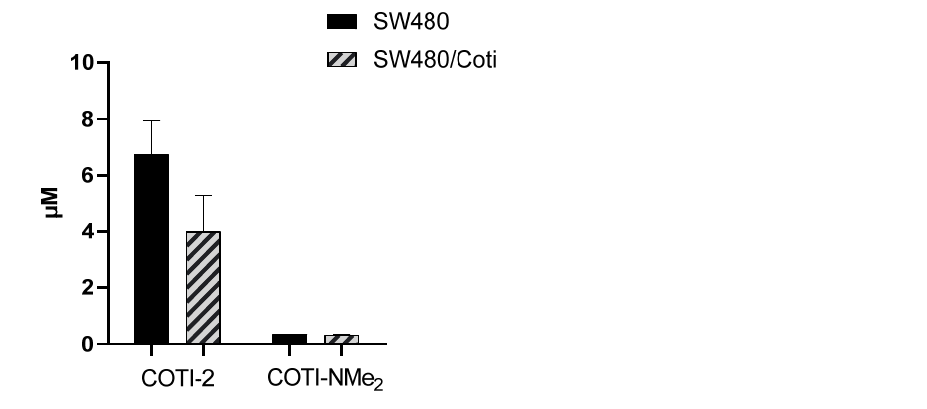
Figure 10. LC-MS measurements of the intracellular levels of free COTI-2 and COTI-NMe 2 in SW480 and SW480/Coti cells incubated with a 10 µM drug concentration for 3 h.